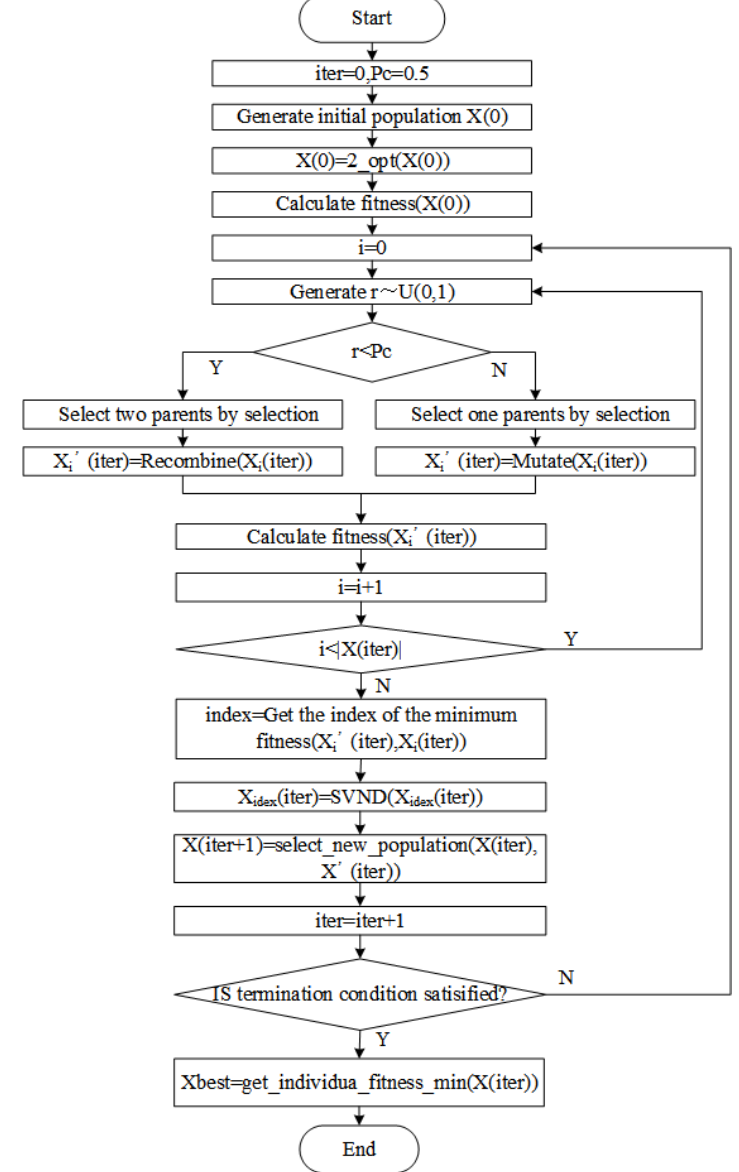
Figure 3. Flowchart: Hybrid Memetic